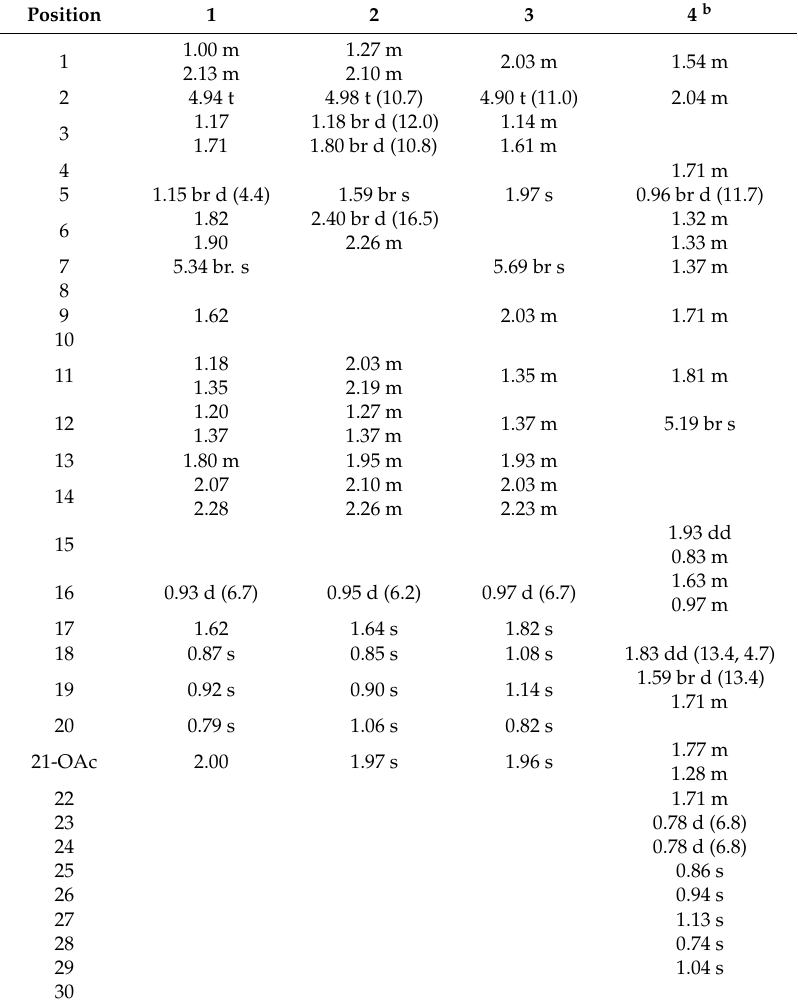
Table 1. 1 H-NMR spectral data (500 MHz, CDCl 3 ) of compounds 1 – 4 a